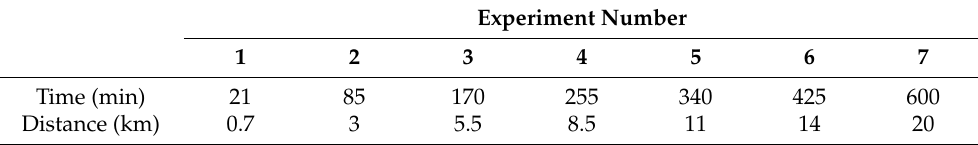
Table 1. Time and distance of transport in each experiment—both are cumulative.